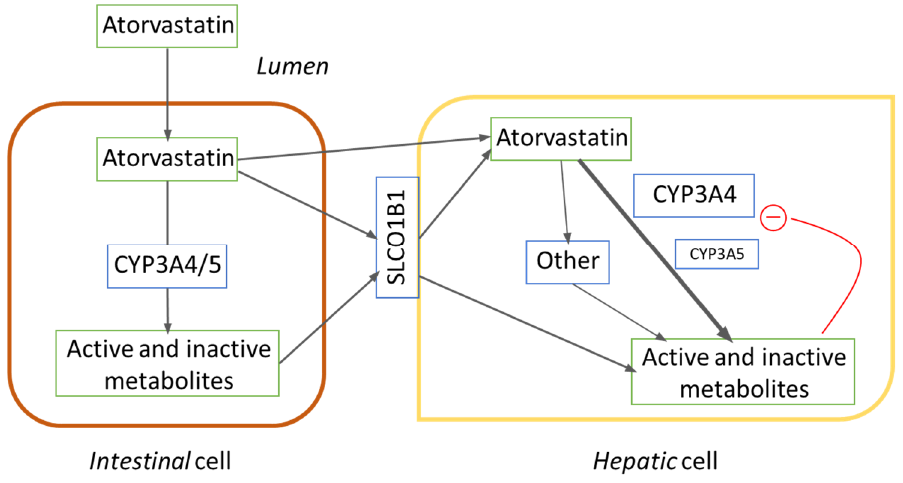
Figure 1. The pharmacokinetic pathway of atorvastatin focused on CYP3A and SLCO1B1. In theory, the higher metabolic capacity of CYP3A5 expressers would be